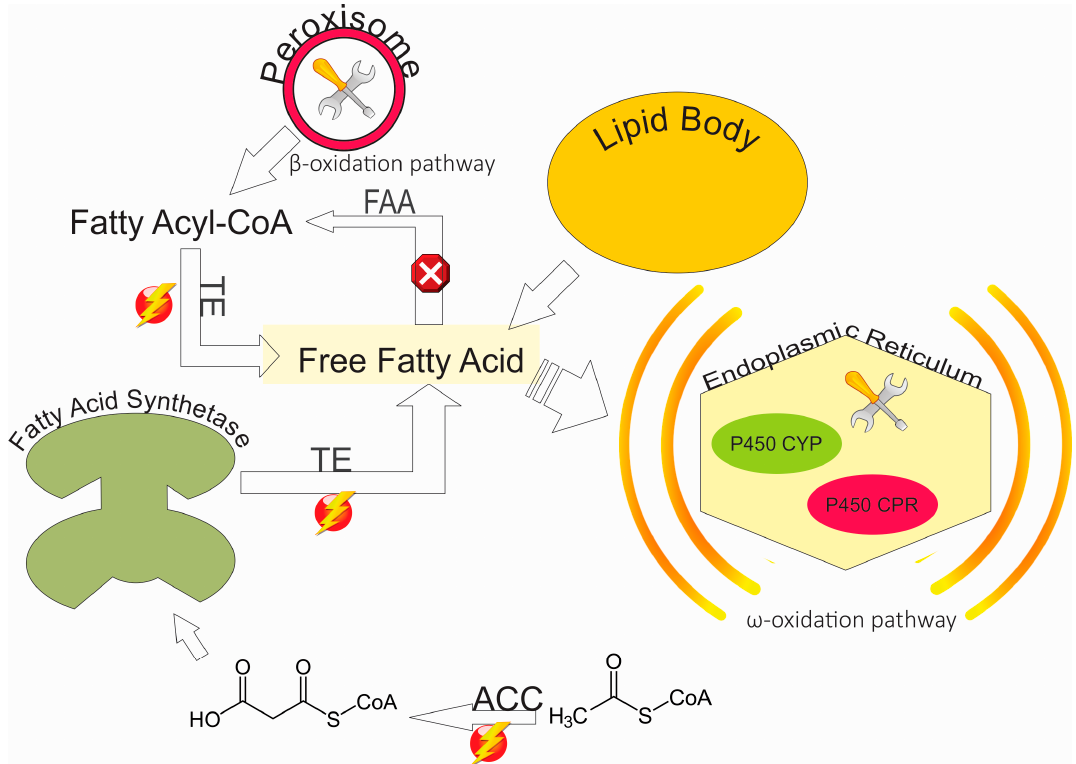
Figure 8. Genetic engineering strategies for the de novo production of oxygenated fatty acid monomers: overexpression of acetyl-CoA carboxylase (ACC) for higher carbon flux re-direction toward fatty acid biosynthesis pathway, overexpression of length specific thioesterases (TE) for the hydrolysis of acyl-CoA and consequently mitigation of their feedback inhibition effect, inactivation of the fatty acyl-CoA synthase (FAA) for the prevention of free fatty acid re-activation, inactivation or reversal of the β -Oxidation cycle for enhancing fatty acid pool and preventing degradation of fatty acid derivatives, and selective upregulation of the ω -oxidation pathway for the terminal oxidation of endogenous fatty acids to their oxygenated counterparts.